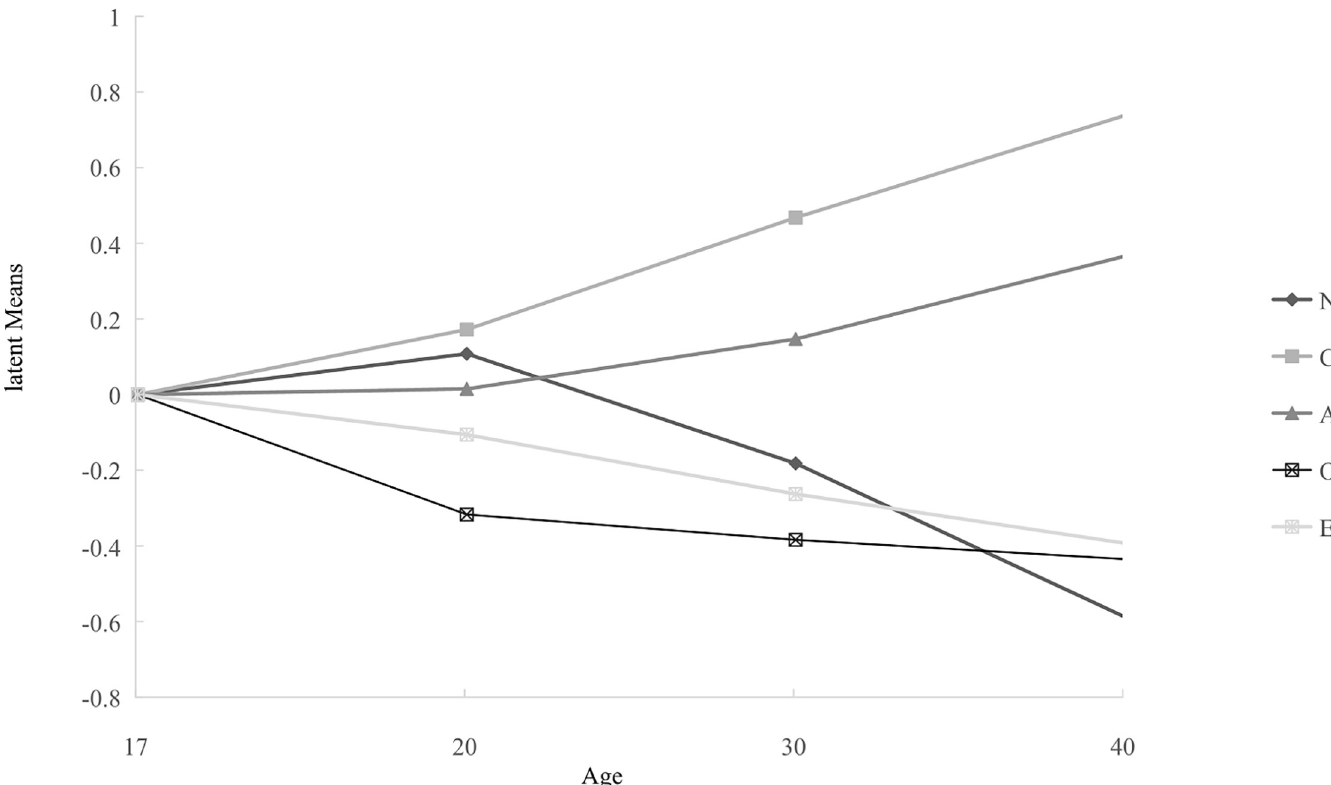
Fig 3. Latent means of females’ Big Five dimensions results across different age